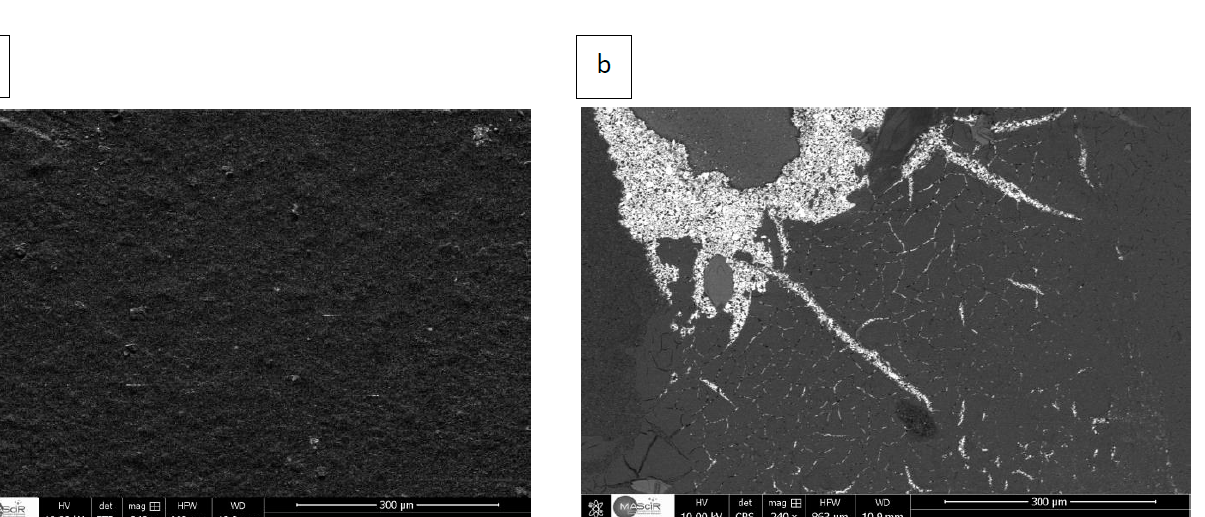
4 of 11 Figure 2. Fabrication process for 3D-PMED. ( a , b ) Coating cellulose paper with wax (crayon) on a heated surface, so only the exposed areas remain hydrophilic; ( c , d ) 3D PMED with sweat collector